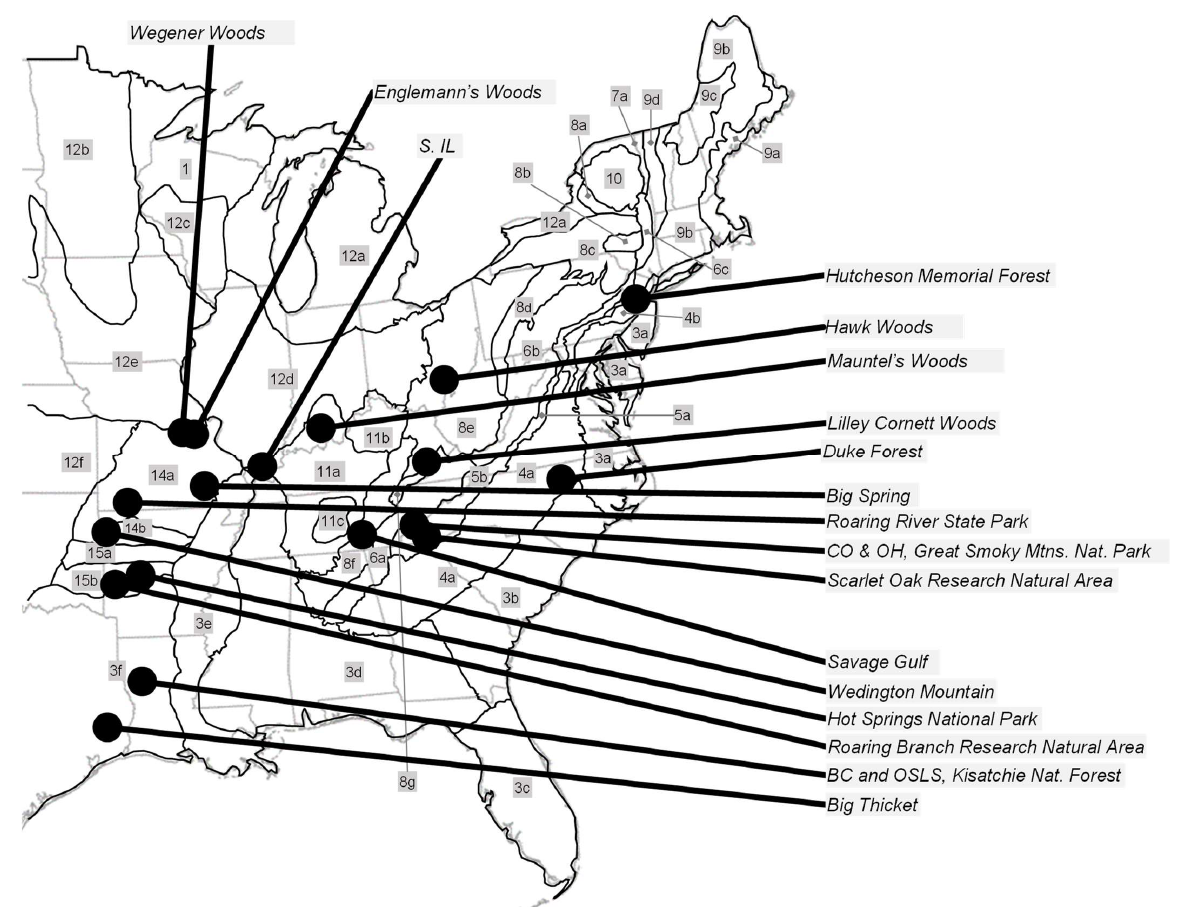
Figure 1. Map of the dry-mesic old-growth sites discussed in this manuscript by physiographic region. Grey lines are state boundaries and black lines are physiographic region boundaries. BC represents Bob’s Creek and OSLS represents Old Shortleaf Slope stand. Physiographic Region codes